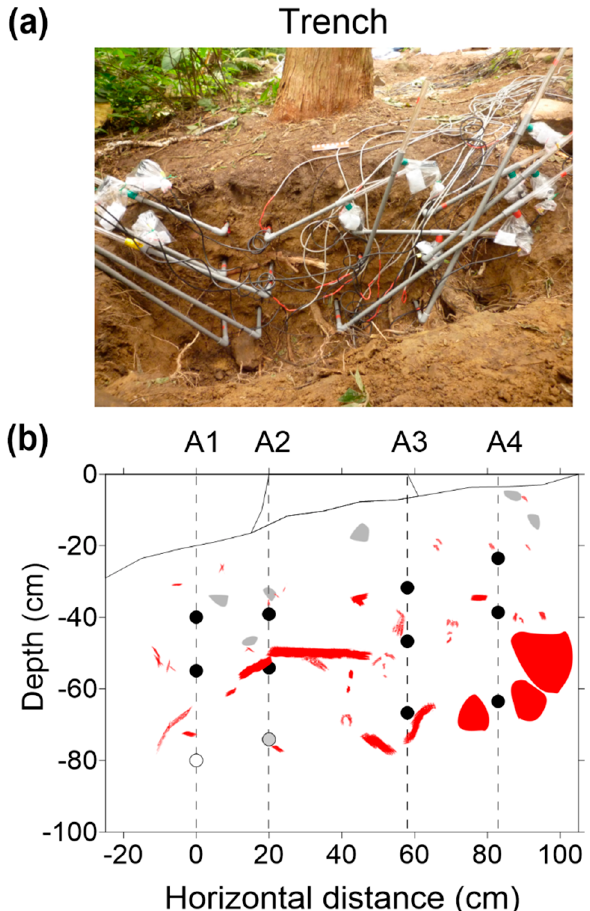
Figure 2. ( a ) Photographs and ( b ) sketches of the distribution of roots along the soil profile in the observation trench. In Figure 1b, A1–A4 indicate the vertical measurement lines, and grey and red shapes indicate the shape and size of rocks and roots observed in the profile exposed by the trench, respectively. Solid black circles indicate installation points of T-TDR probes that successfully monitored both soil water content and soil water potential during the observation period; a grey circle and an empty circle indicate points missing soil water content data, and missing both soil water content and soil water potential, respectively.